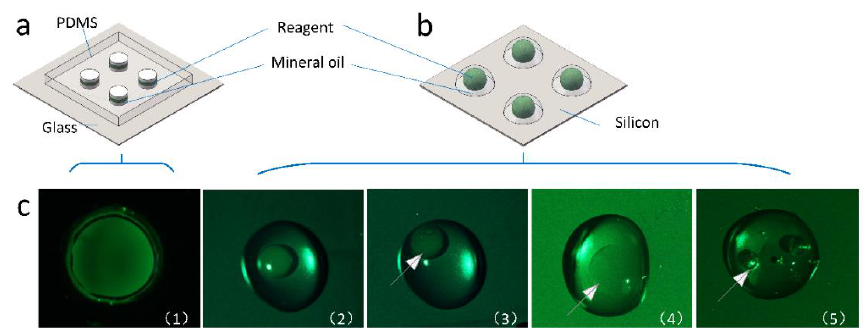
Figure 2. Comparison of the new and previous chip designs. ( a ): current microchips. ( b ): the previous microchips. ( c ): issues with the previous microfluidic chip: (1) droplet after the reaction on the homemade chip, (2) droplet before the reaction, (3) off-center droplet during the injection, (4) sample evaporation during the reaction, and (5) bubbles forming during the reaction.